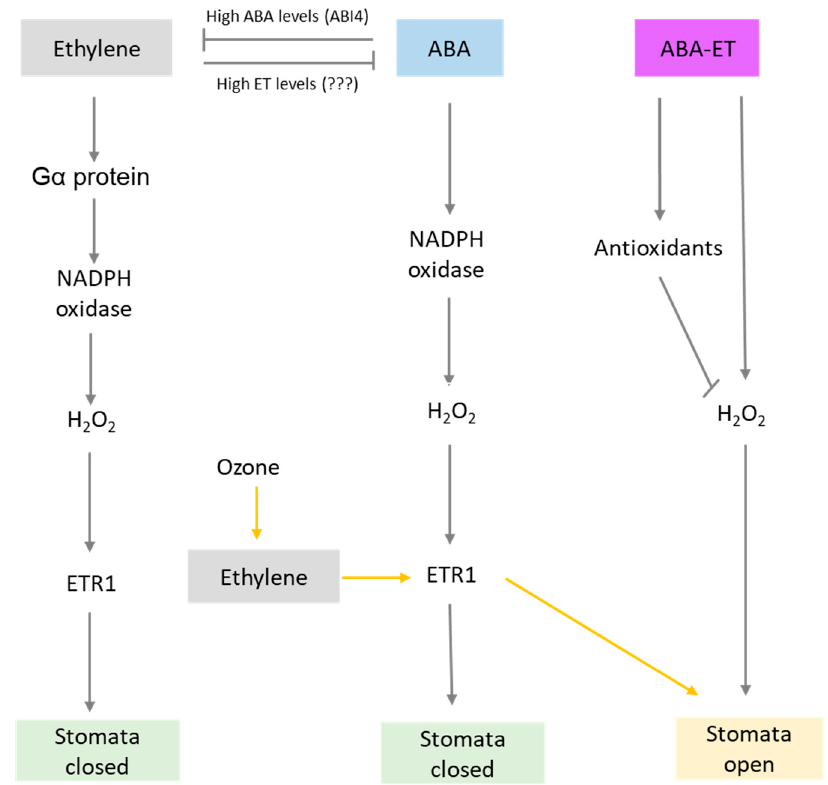
Figure 1. Hypothetical mechanism(s) regulating stomatal closure or opening. ABA and ethylene can individually regulate stomatal closure via H 2 O 2 and ETR1. While high levels of ABA can inhibit ethylene and vice versa. However, the presence of both ABA and ethylene (ABA–ET) induces antioxidant activity, which in turn reduces H 2 O 2 contents and thus diminishes stomatal closure (half-open stomata). Under ozone stress, ethylene binds to ERT1, which inhibits the ABA response pathway leading to open stomata (indicated by yellow arrows).